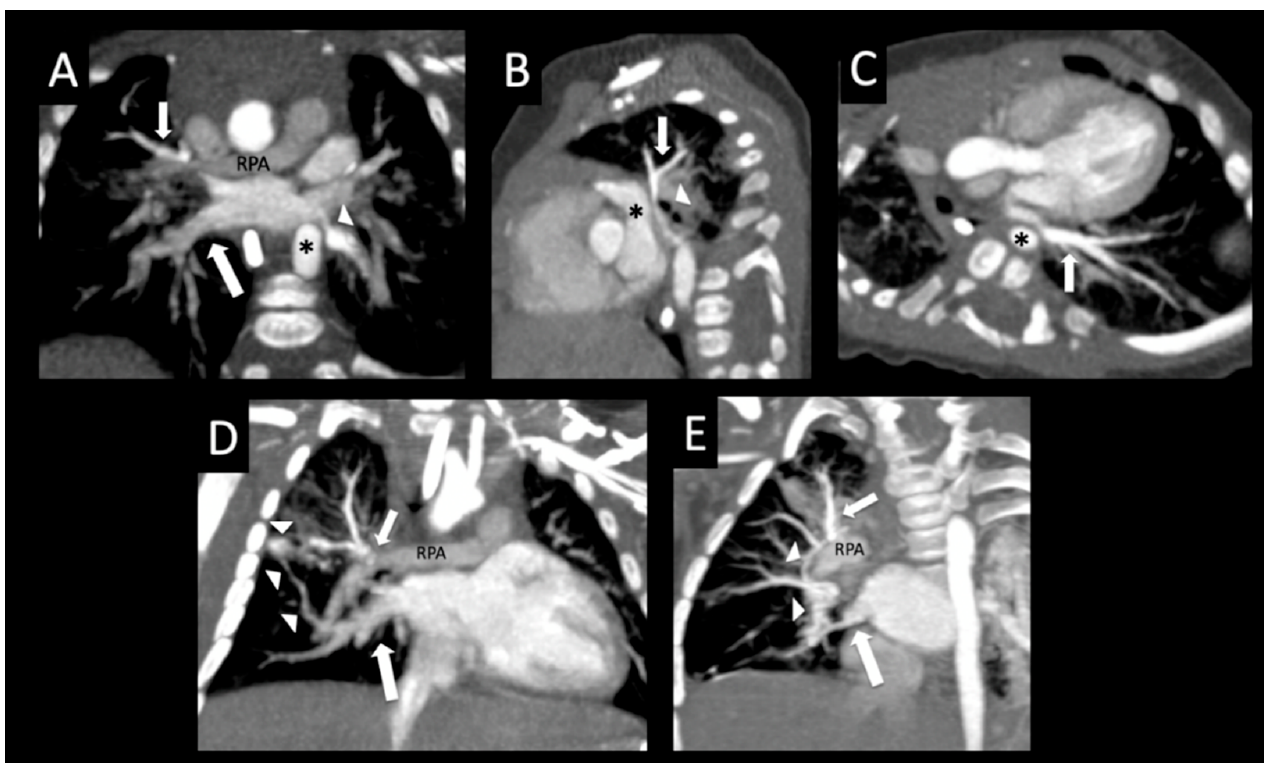
Figure 5. Bilateral pulmonary vein stenosis. Former 35-week triplet with chromosome 2 duplication and primary pulmonary vein stenosis affecting all pulmonary veins except right lower pulmonary vein. Oblique coronal image ( A ) shows moderate ostial stenosis of the left lower pulmonary vein (arrowhead) coursing anterior to the descending aorta (*), atresia of the mid right upper pulmonary vein (small arrow) as it crosses the right pulmonary artery (RPA), and an unobstructed right lower pulmonary vein (large arrow). Sagittal oblique image ( B ) shows extrinsic compression of the left upper pulmonary vein (arrow) coursing between the left atrial appendage (*) and left bronchus (arrowhead). Oblique axial image ( C ) shows moderate extrinsic compression of the left lower pulmonary vein (arrow) from the descending aorta (*). The left upper pulmonary vein ( B ) and left lower pulmonary vein ( A , C ) have more dense peripheral enhancement due to central stenosis. Coronal oblique image ( D ) shows focal atresia of the mid right upper pulmonary vein (arrow) at the level of the right pulmonary artery (RPA), and a peripheral network of tiny collaterals (arrowheads) connecting to the right lower pulmonary vein (large arrow). Coronal oblique image ( E ) shows an additional network of intrapulmonary collaterals (arrowheads) coursing around the right pulmonary artery (RPA), which connect the right upper pulmonary vein (small arrow) to the right lower pulmonary vein (large